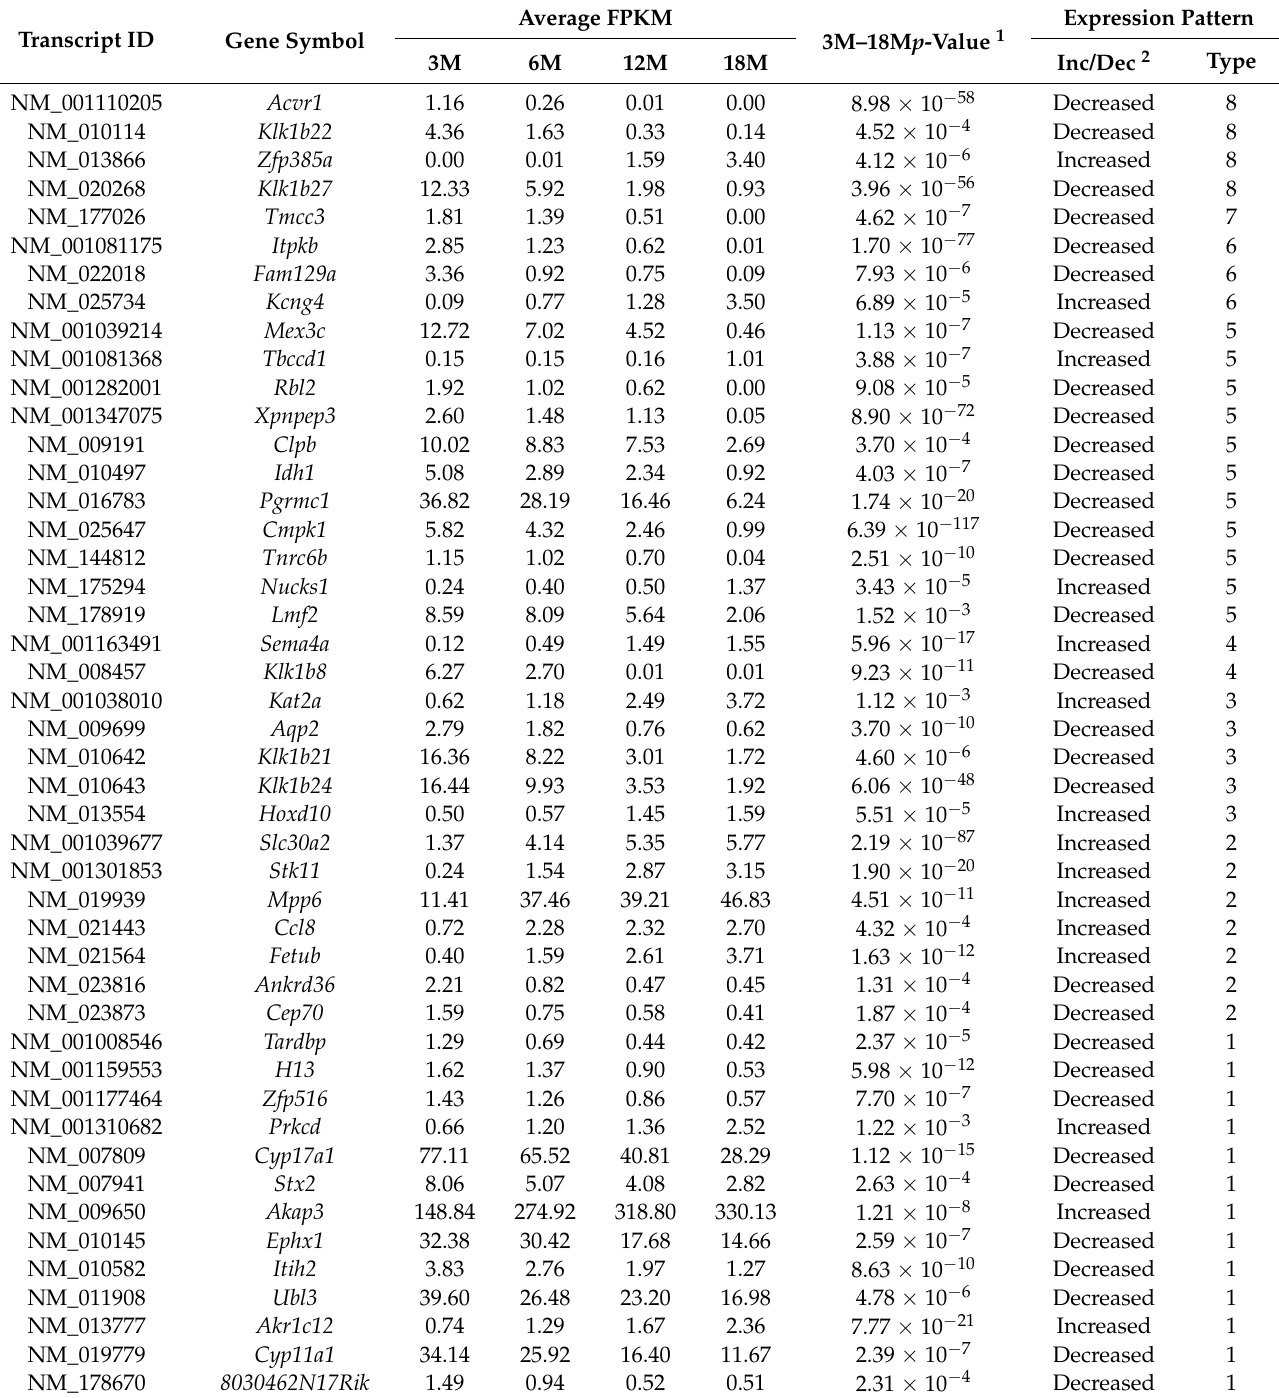
Table 3. Expression changes and classified patterns of aging-related